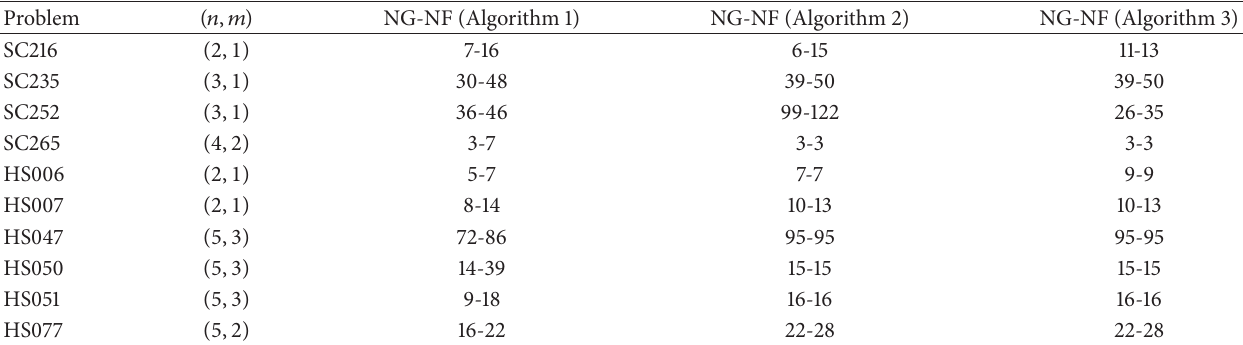
Table 2: Comparison among three algorithms for same problems in [31,